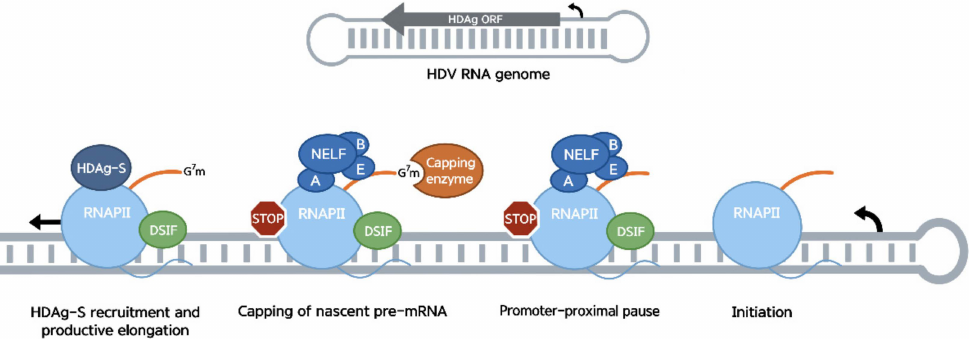
Figure 4. RNAP II initiates transcription on the HDV RNA genome. Transcription is paused ~40 nucleotides after initiation, following recruitment of DSIF and NELF to the polymerase. Once the nascent transcript is capped, HDAg-S is recruited to the stalled complex where it competes with NELF-A for a common binding site on RNAP II. HDAg-S displaces NELF from RNAP II, stimulating processivity of the polymerase and therefore entry into productive